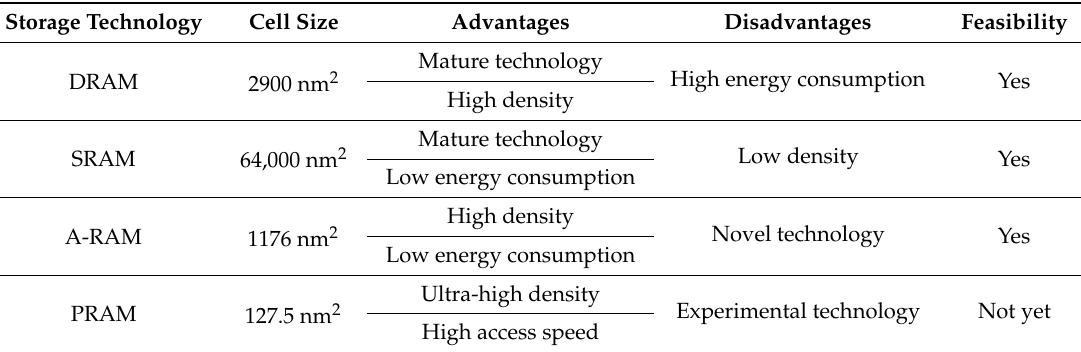
Table 3. Comparison of RAM memory